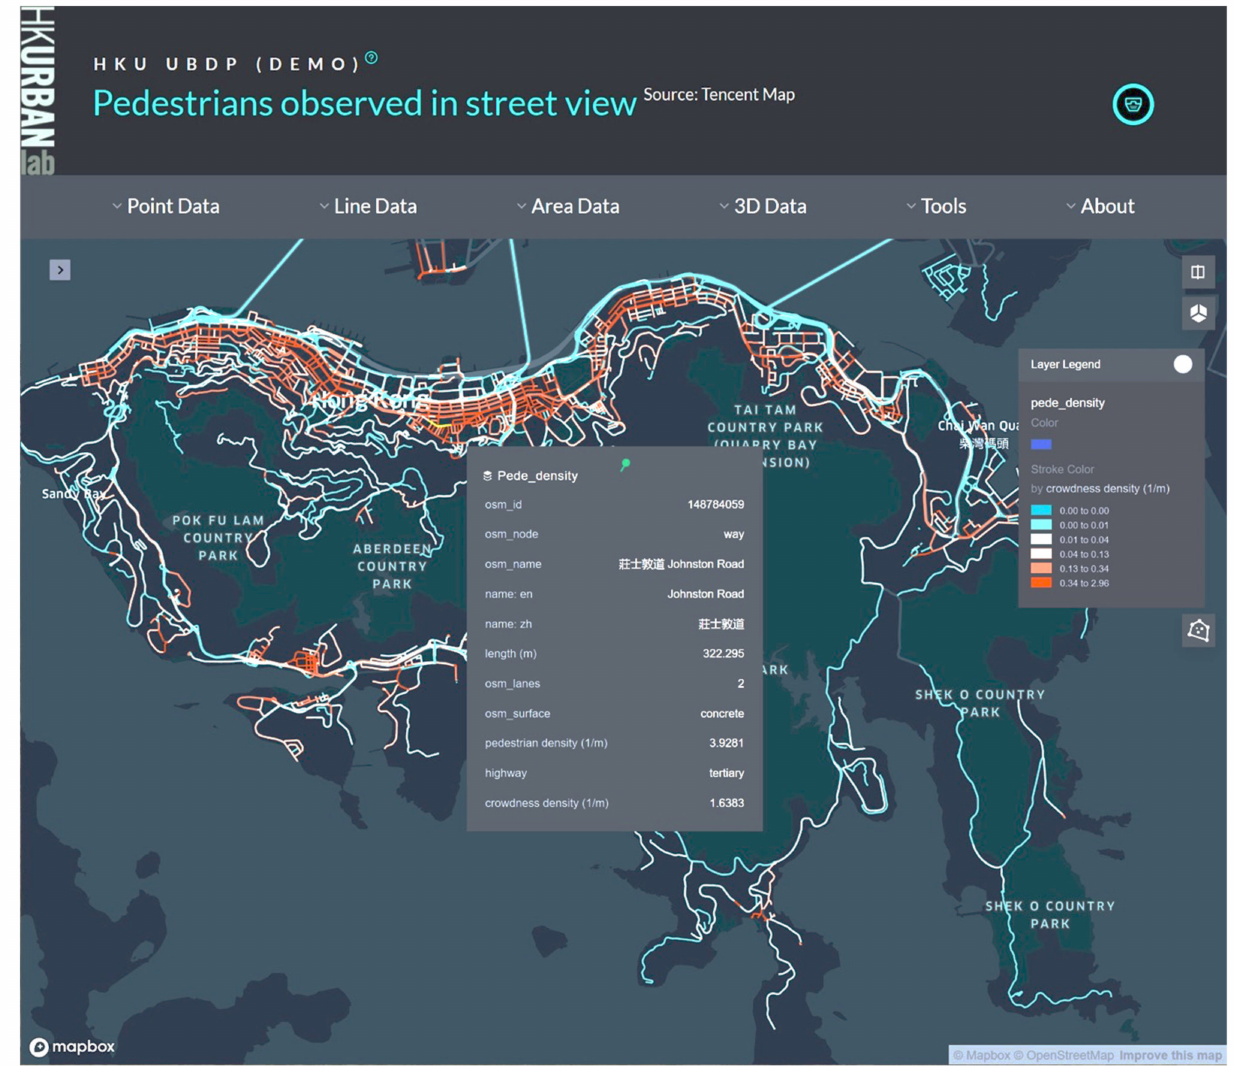
Figure 12. Visualization of the GeoJSON file consisting of enriched OpenStreetMap nodes, where the warmer colors indicate higher densities of pedestrians on the